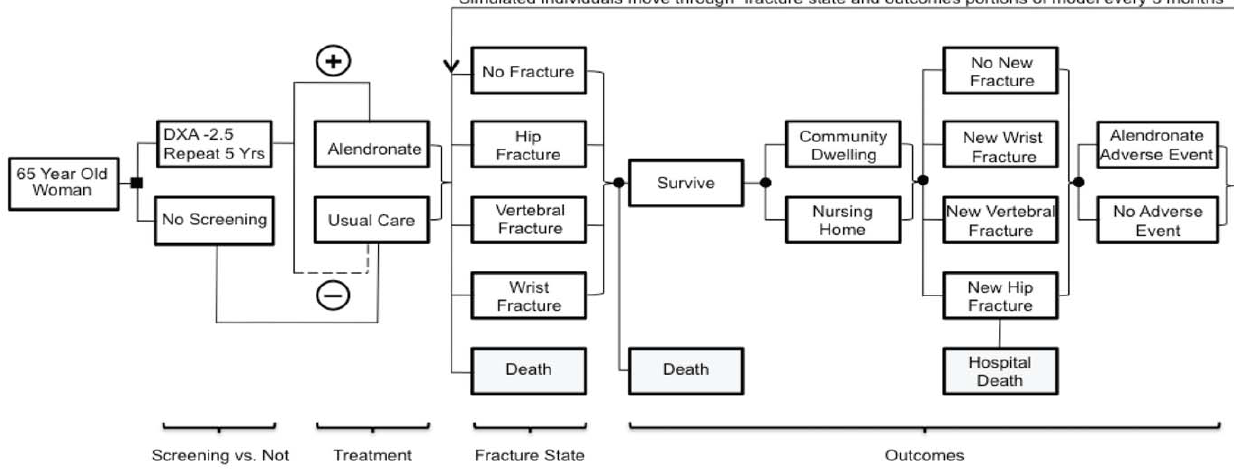
Figure 1. Model Schematic. A simplified and partial representation of the full model.